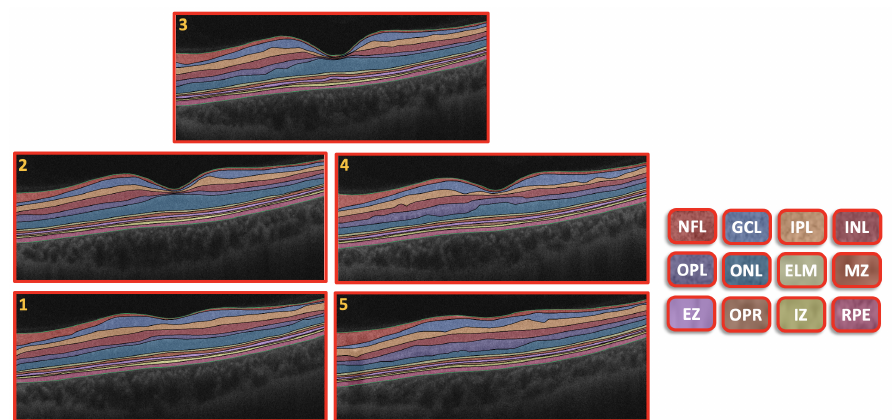
Figure 2. Retinal segmented layers starting from NFL layer and ending with RPE